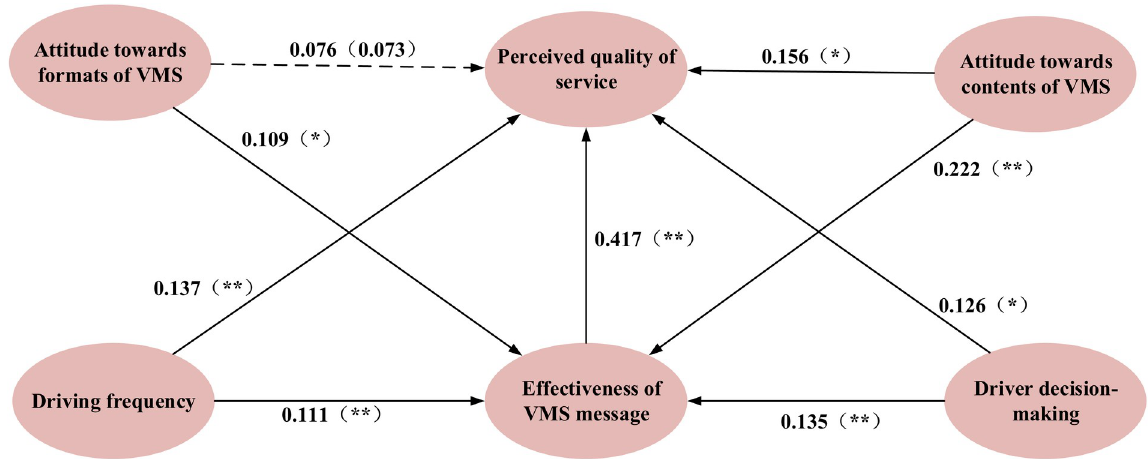
Fig 6. Estimated results of MIMIC model for office car owners (Model II). Notes: �� Coefficients are statistically significant at the 5% level ( � p < 0.05. �� p < 0.01).